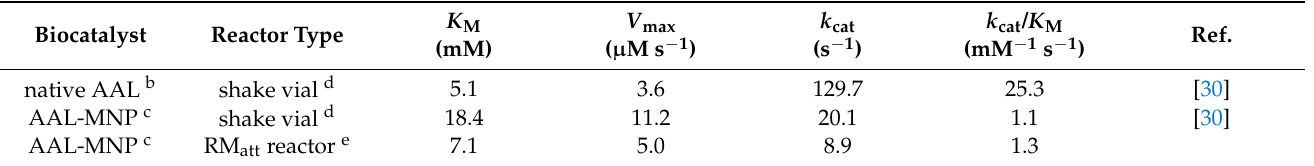
Table 1. Effective kinetic parameters of aspartate ammonia-lyase in various reaction modes